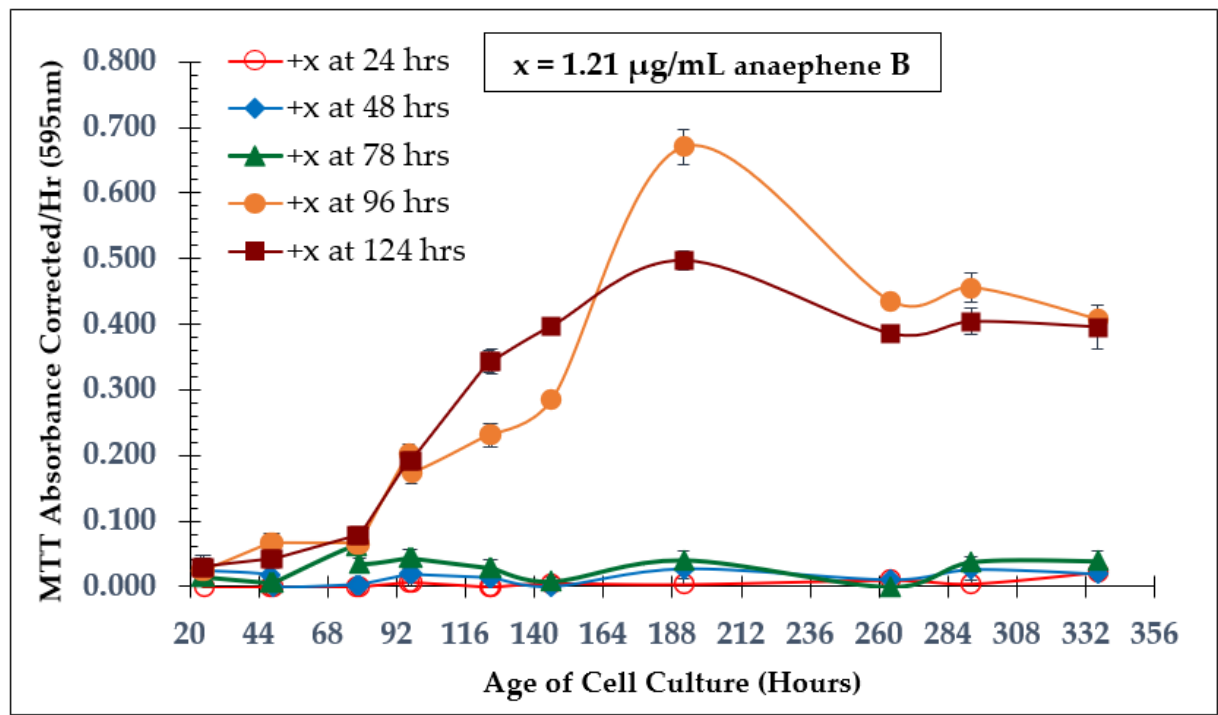
Figure 2. Time of Addition Study—Natural Product Anaephene B (1.21 µg/mL). Compound was added to each flask at different times to assess how time of addition affected the inhibition of L. tarentolae . Values are the mean and standard deviation for n = 4 replicates.